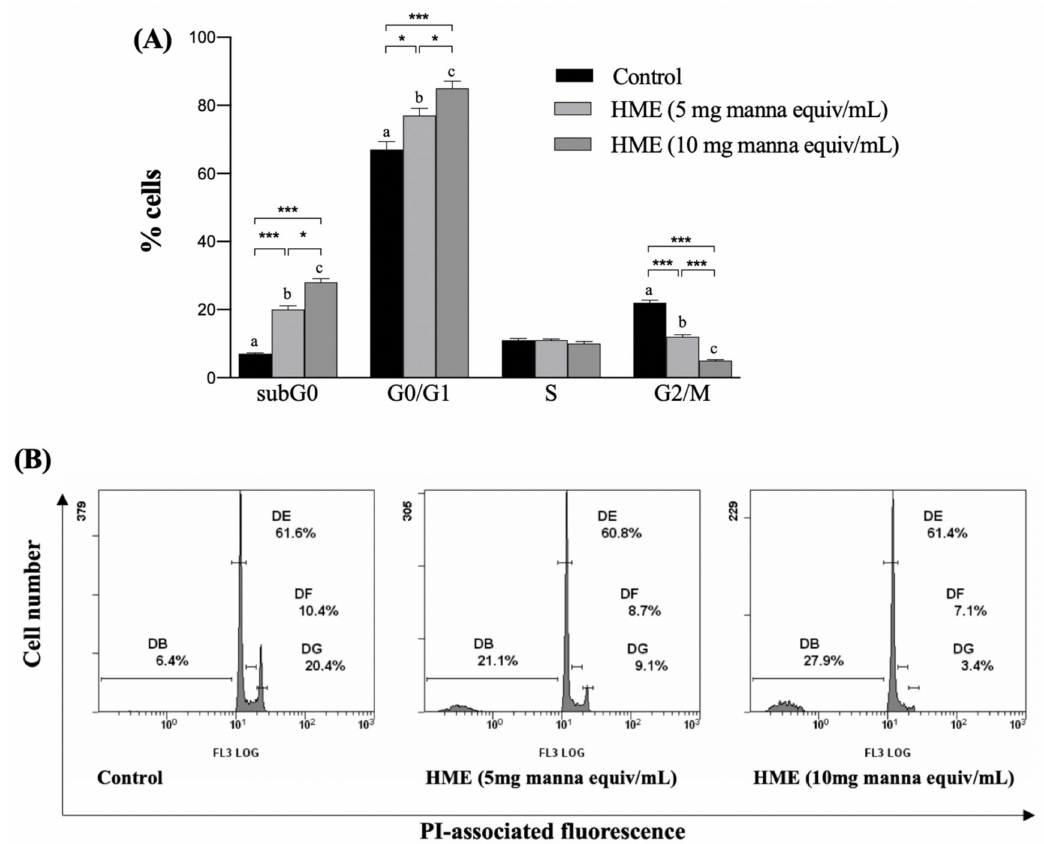
Figure 6. E ff ect of HME on the cell cycle distribution of HCT-116 cells. Cell were treated for 24 h as reported in Methods. Then, samples were submitted to flow cytometry analysis after propidium iodide (PI) staining and cell distribution compared to untreated cells (control). ( A ) Mean values ± SD of three separate experiments in triplicate. Within each group, means with di ff erent letters are significantly di ff erent (one-way Anova associated with Tukey’s post hoc test) with * p < 0.05; *** p < 0.001. ( B ) Representative